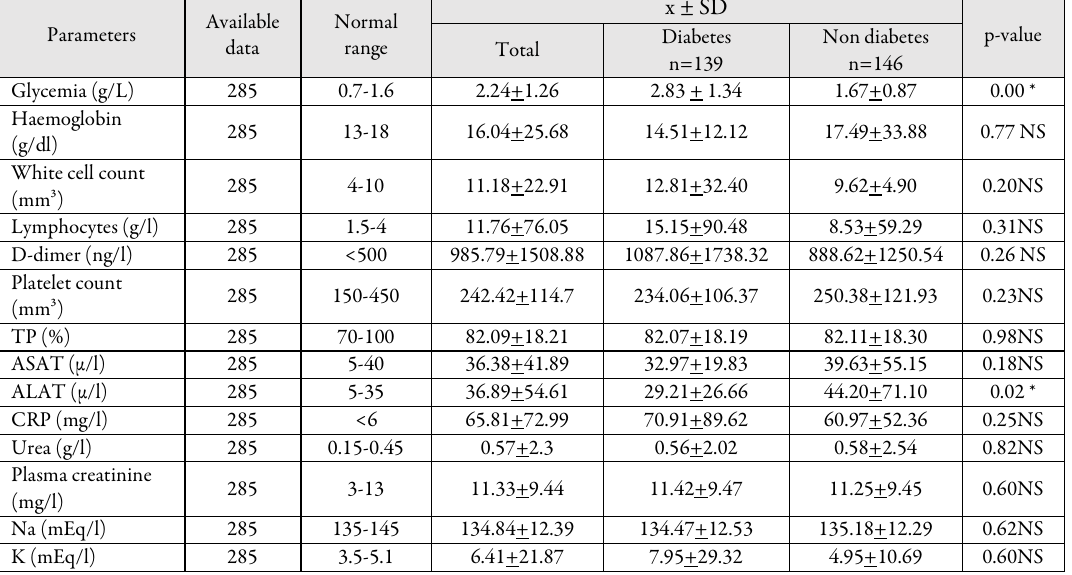
Table 4. Comparison of laboratory parameters between diabetic and non-diabetic COVID-19 patients